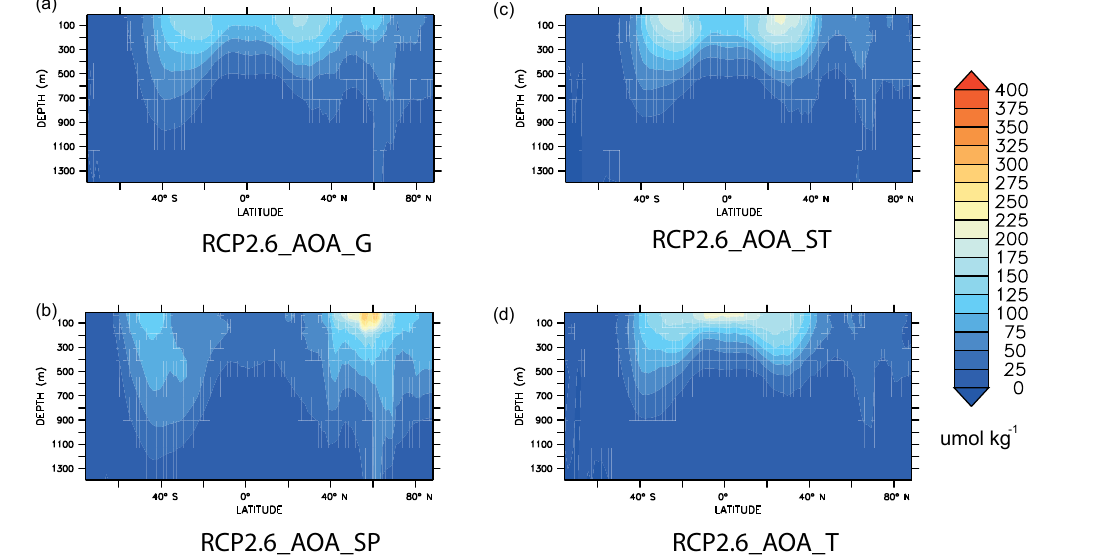
Figure 4. The zonal mean changes in alkalinity in the interior ocean associated with global and regional AOA under RCP8.5 in 2090 (mean; 2081–2100) relative to RCP8.5 with no AOA. Units are µmolkg − 1 .